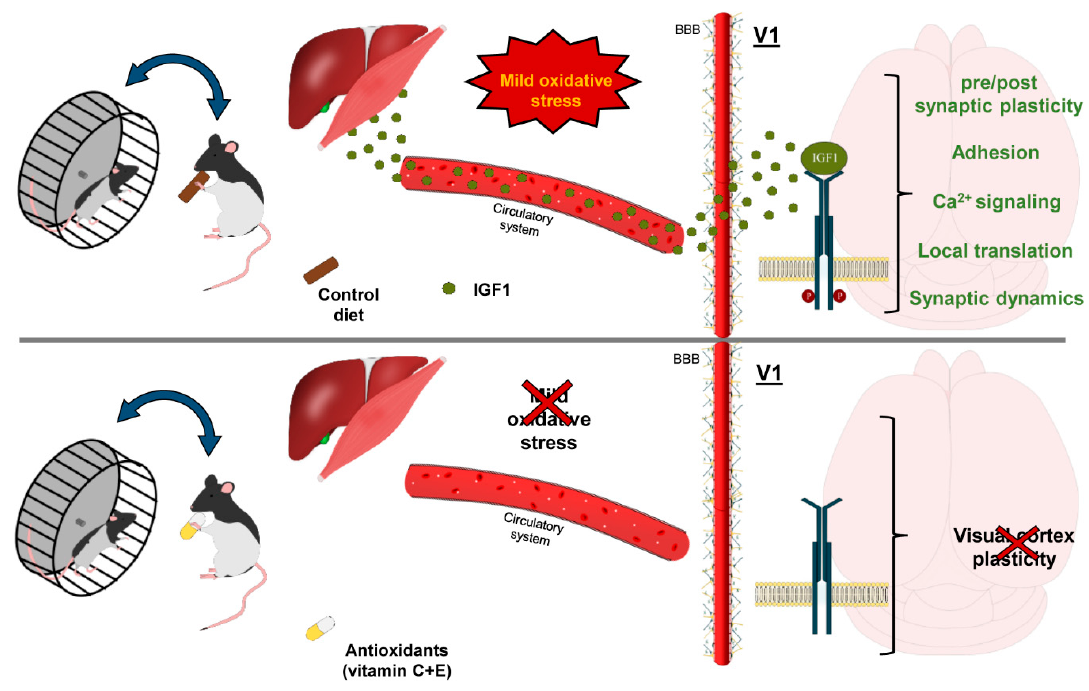
Figure 7. A schematic model of mithormesis in response to physical activity and of the antioxidant effects.